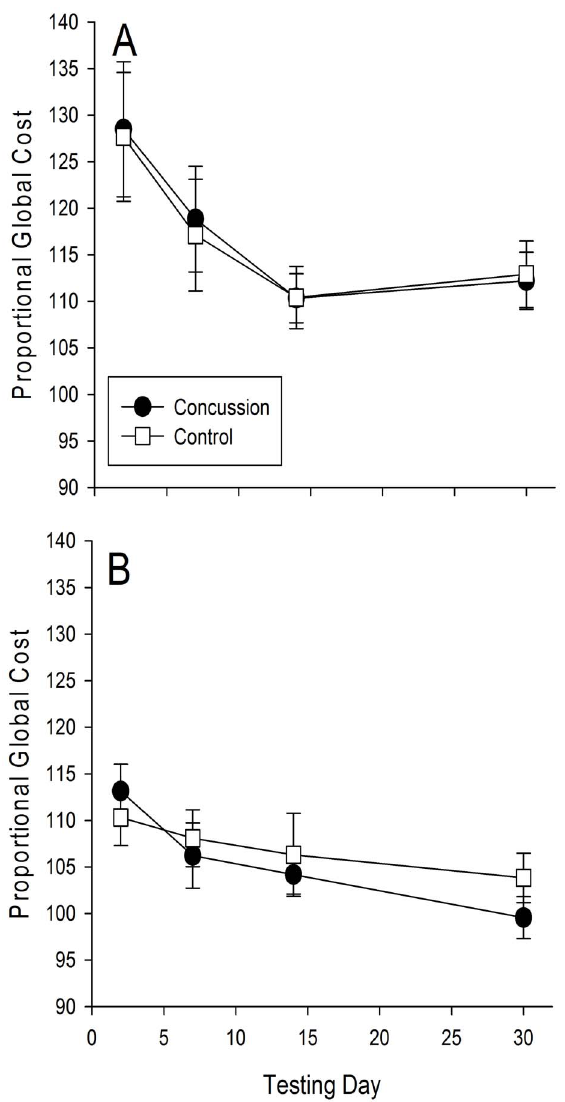
Figure 3. Global Cost. Global cost across the 4 testing days in the spatial (A) and numerical (B) versions of the switch task for the participants with concussion ( black circles ) and controls ( white squares ). Error bars, 1 intersubject SE .